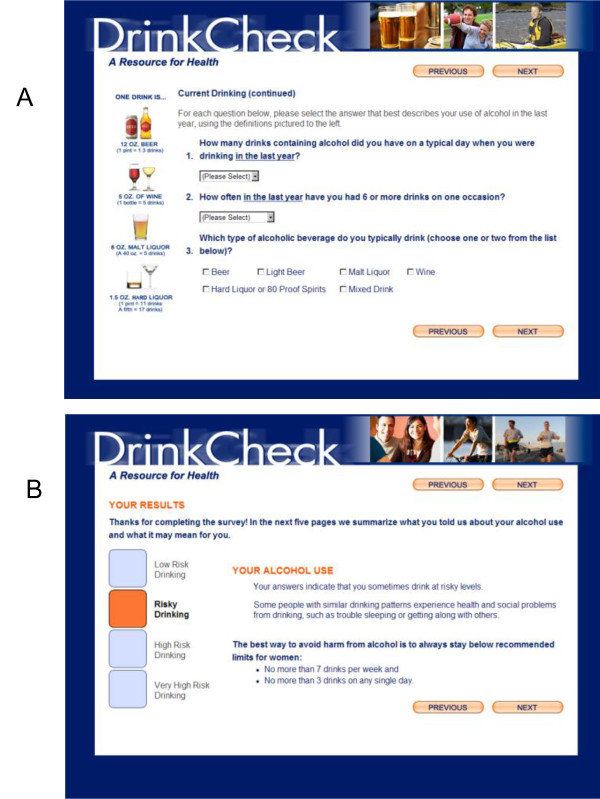
Screenshots of the DrinkCheck e-SBI tool adapted for OEF/OIF veterans.A—alcohol assessment questions; B—initial feedback page.